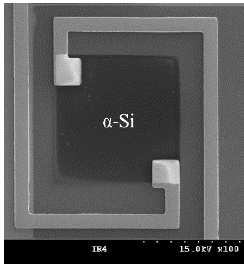
Figure 2. Microscope picture of fabricated bolometer.